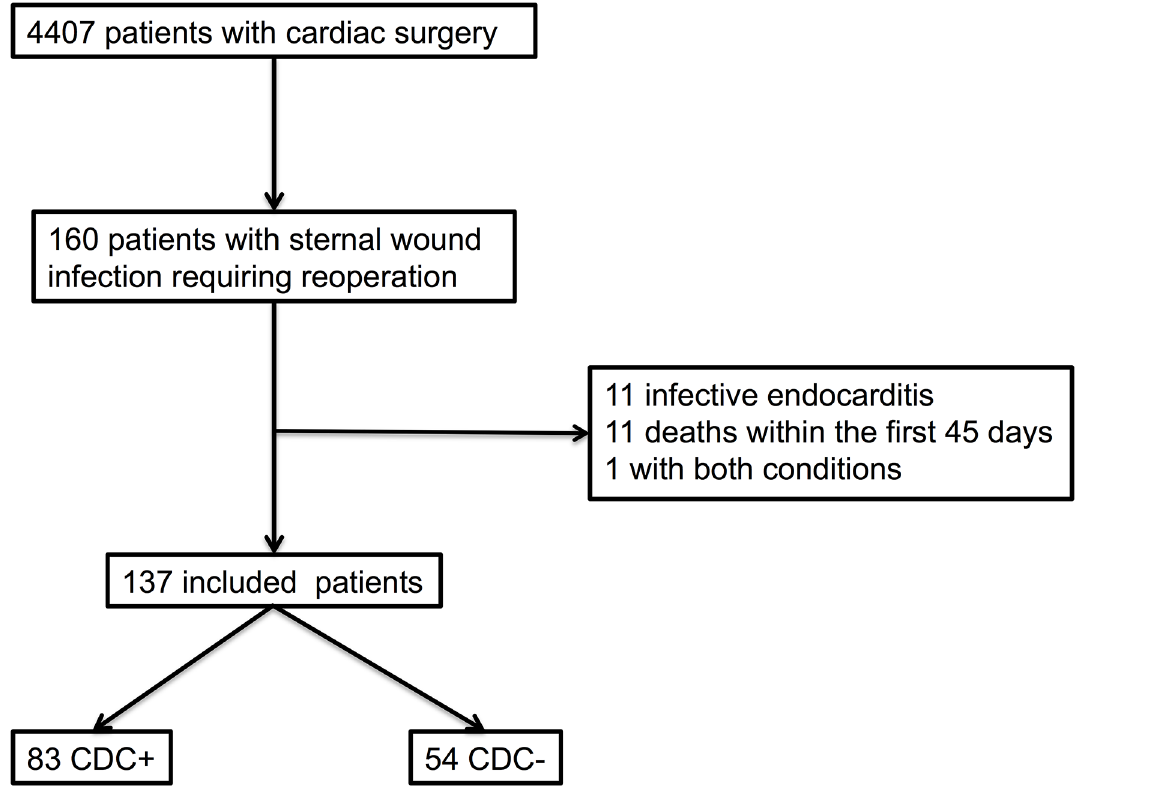
Fig 1. Flow chart of Patients with Sternal Wound Infection Requiring Reoperation after Cardiac